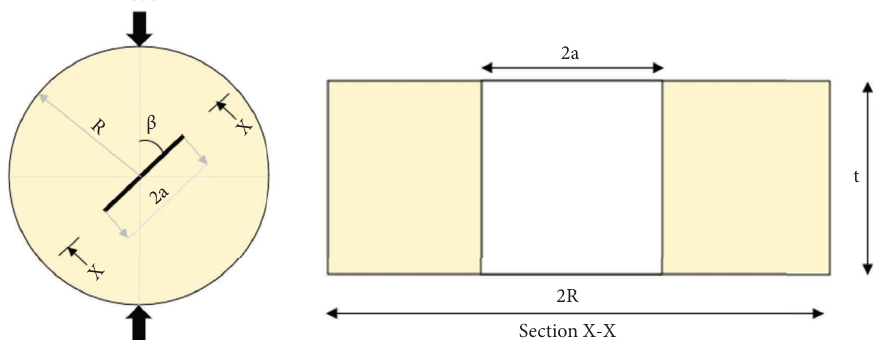
Figure 5: Schematic of the Brazilian disc specimen with a center crack when subjected to compression.